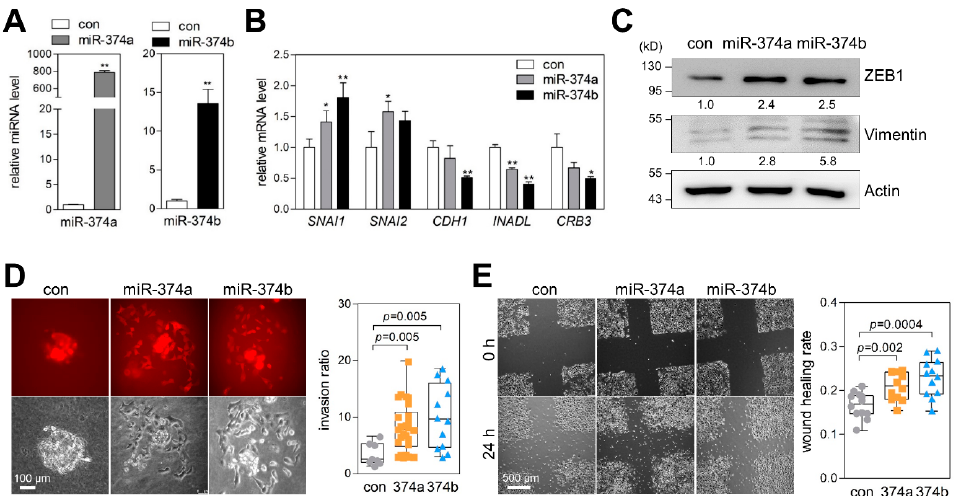
Figure 4. miR-374a and miR-374b promote epithelial-to-mesenchymal transition (EMT), migration, and invasion of lung cancer cells. ( A ) qRT-PCR of miR-374a and miR-374b in miR-374-mimic transfected cells. A549 cells were transiently transfected with miR-374a or miR-374b mimics, and miR-374a (left) and miR-374b (right) -expression levels were measured by qRT-PCR. Expression levels were normalized to that of the small-nucleolar RNA RNU6B . Relative values to those of A549 cells transfected with negative control (set to 1.0) are presented. Data represent the mean + SD ( n = 3). ** p < 0.01; two-tailed Student’s t test. ( B ) qRT-PCR of EMT markers in miR-374-mimic transfected cells. A549 cells were transiently transfected with miR-374a or miR-374b mimic, and mRNA-expression levels of EMT markers were measured by qRT-PCR. Expression levels were normalized to that of RPL32 . Relative values to those of A549 cells transfected with negative control (set to 1.0) are presented. Data represent the mean + SD ( n = 3). * p < 0.05, ** p < 0.01; two-tailed Student’s t test. ( C ) Western blots of EMT markers in miR-374-mimic transfected cells. A549 cells were transiently mimics, and protein levels of EMT markers were measured by Western blot. Actin was used as a loading control. Densitometric quantification is presented below the blots. ( D ) Spheroid invasion assay in miR-374-mimic transfected cells. Spheroids made from hanging-drop cultures of miR-374-mimic transfected A549 cells were seeded on collagen gels and then cultured for 24 h. A549 cells were labeled with mCherry by retroviral infection. Spheroid invasion ratios (ratio of whole cell area to the central spheroid area) were measured using ImageJ software. Box-and-whisker plots denote median and upper / lower quartiles + 1.5 × interquartile range. Con, n = 8; 374a, n = 26; 374b, n = 12. P ,